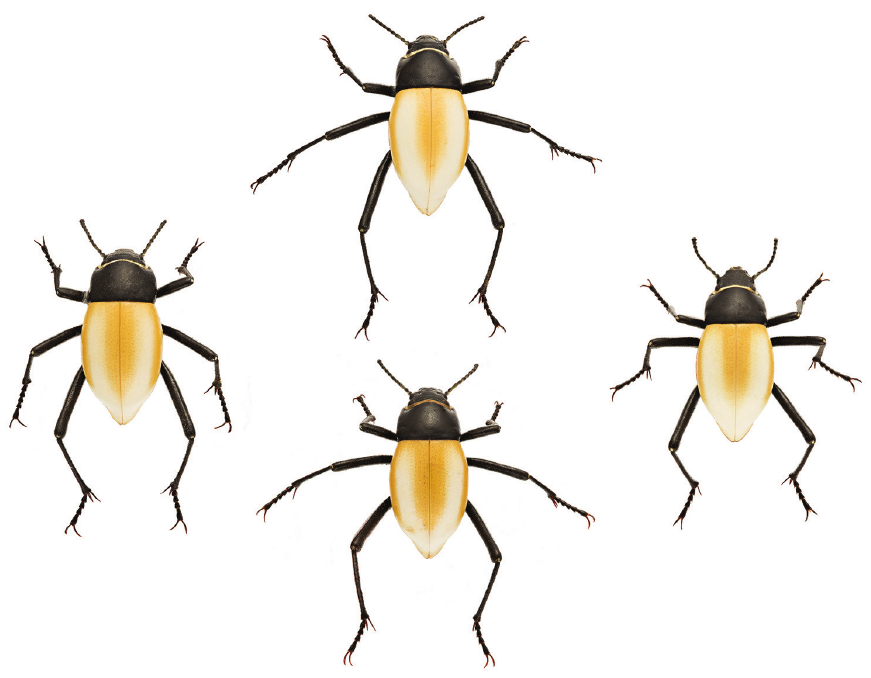
Figure 3. Specimens of Onymacris brainei from the second locality, illustrating variation in degree of elytral